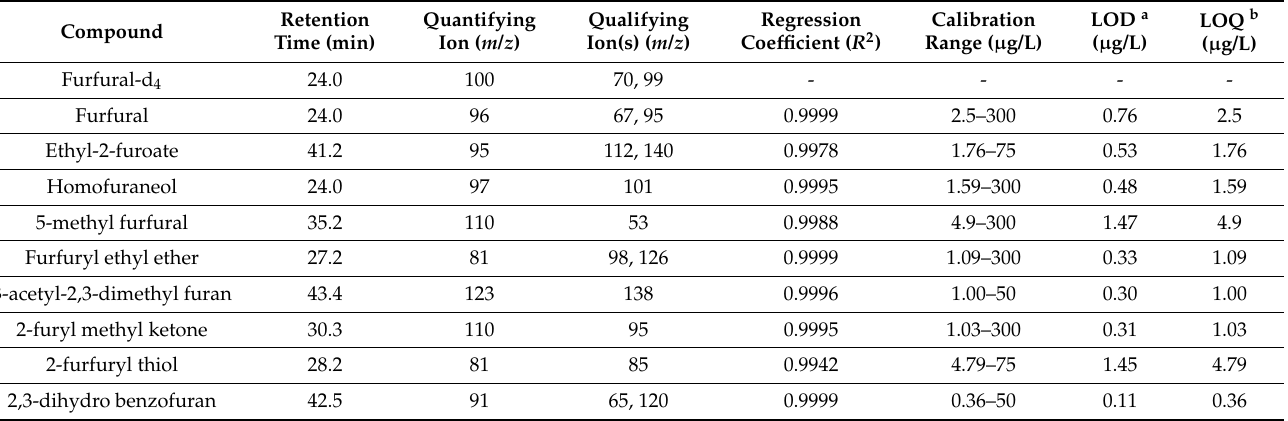
Table 4. Retention times (min), quantifying ions ( m / z ), qualifying ions ( m / z ), regression coefficient ( R 2 ), calibration range ( µ g/L), limits of detection (LODs), and limits of quantification (LOQs) of all furan-derived compounds